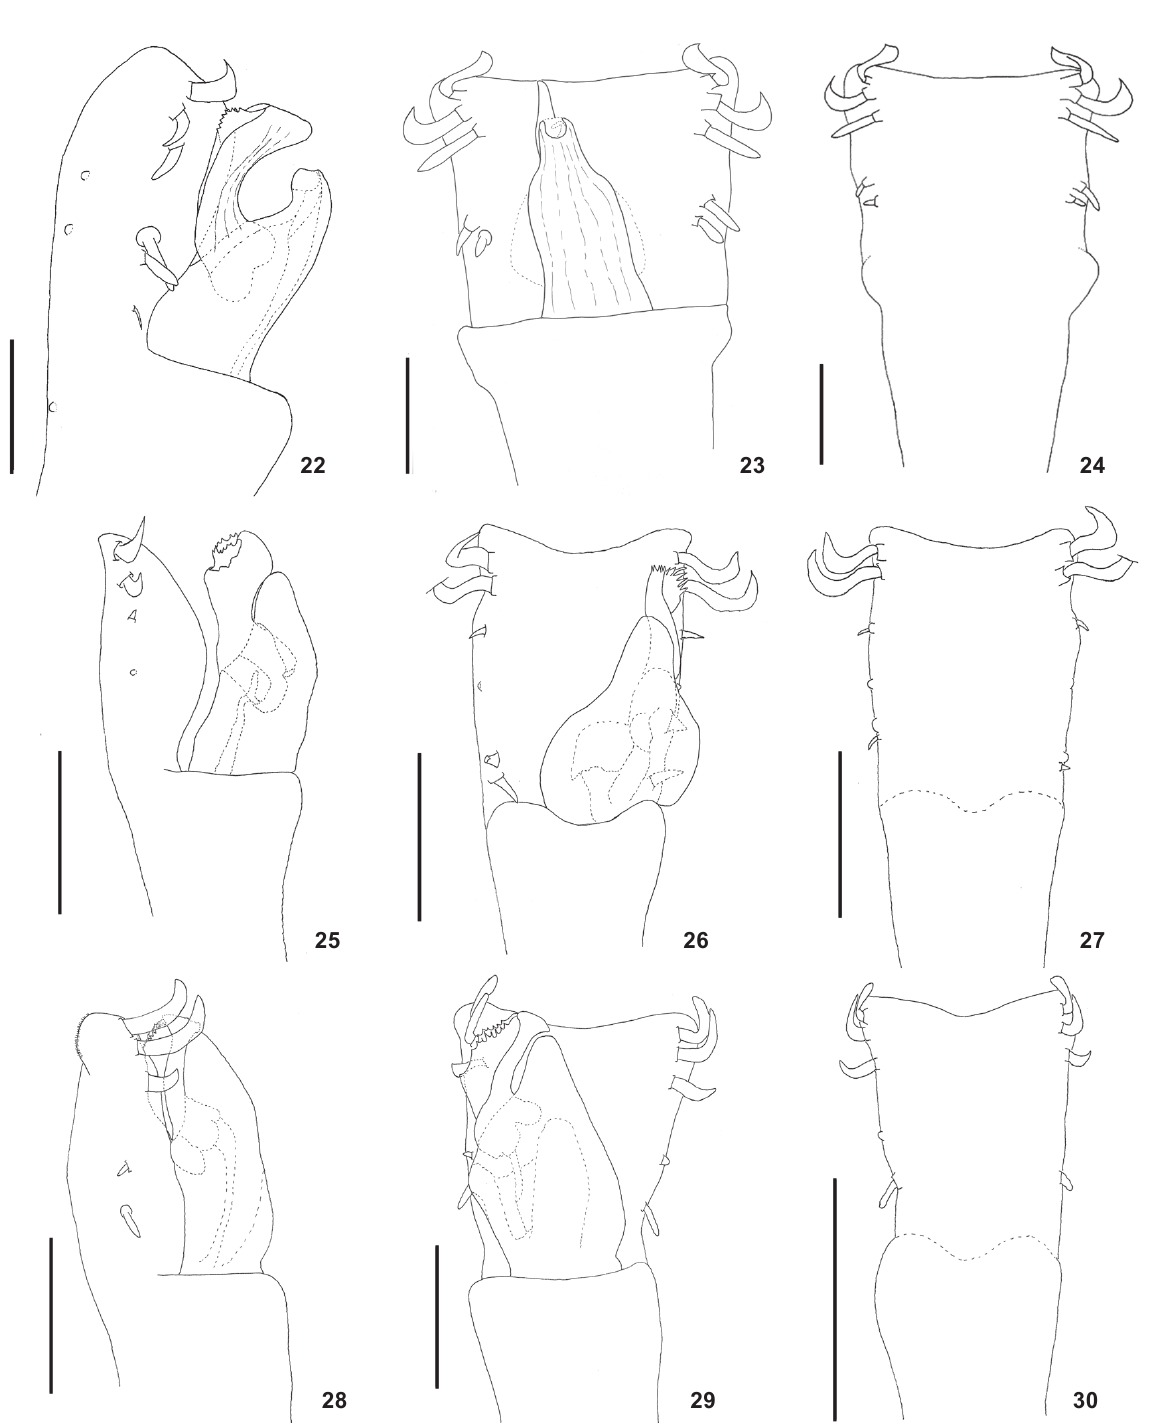
Figures 22-30. Penis of Cosmetus . (22-24) Cosmetus tamboritos sp. nov. (MIUP): (22) lateral view; (23) dorsal view; (24) ventral view. (25-27) Cosmetus arietinus (MZSP 14038): (25) lateral view; (26) dorsal view; (27) ventral view. (28-30) Cosmetus variolosus (MZSP 238): (28) lateral view; (29) dorsal view; (30) ventral view. Scale bars = 1